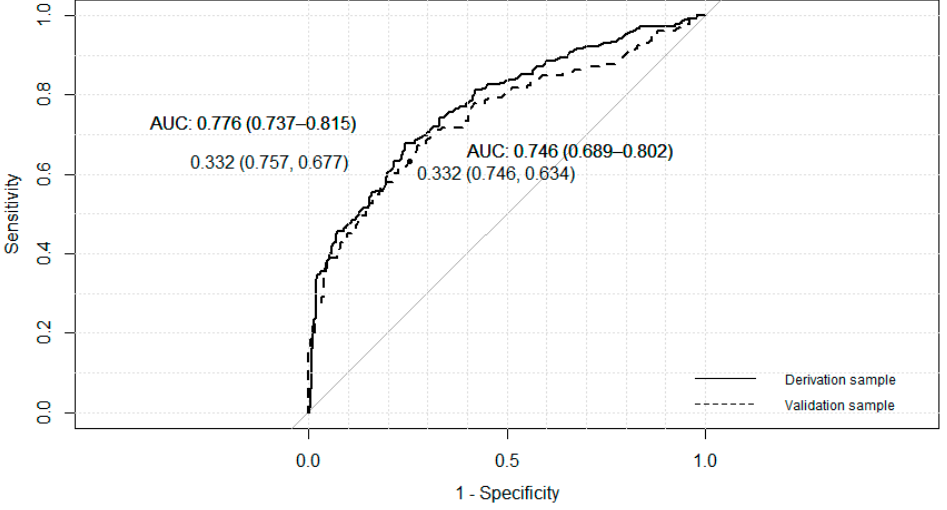
Figure 4. ROC curves for derivative and validation samples, model A, AUC = Area Under the Curve